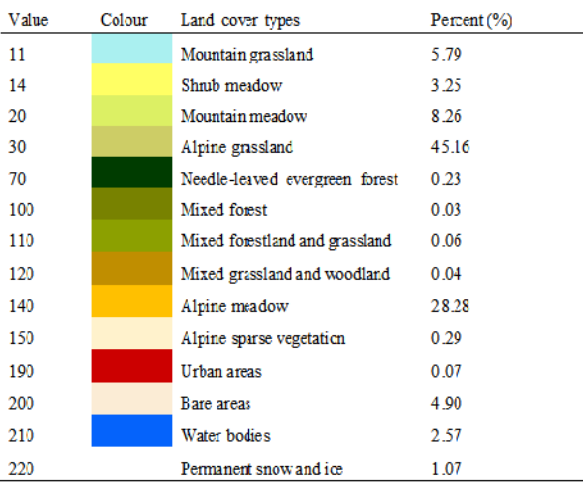
Table 1. Legend of the land cover map on the northern Tibetan